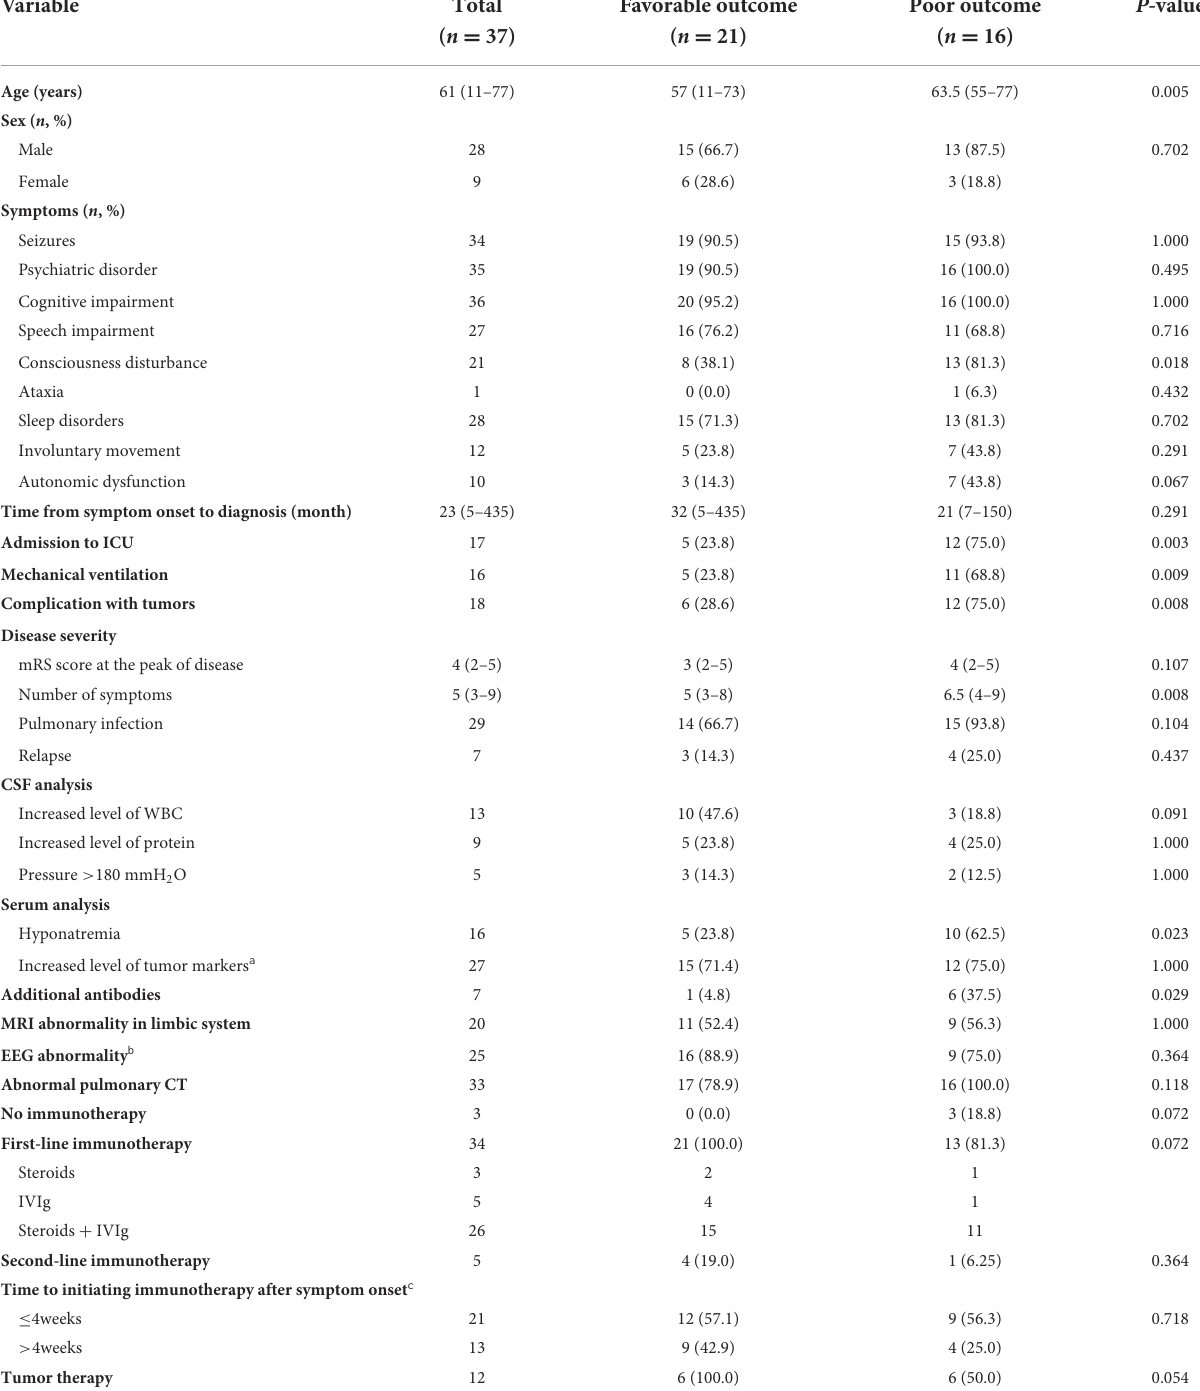
TABLE 1 Clinical data of patients with anti-GABA B R encephalitis according to